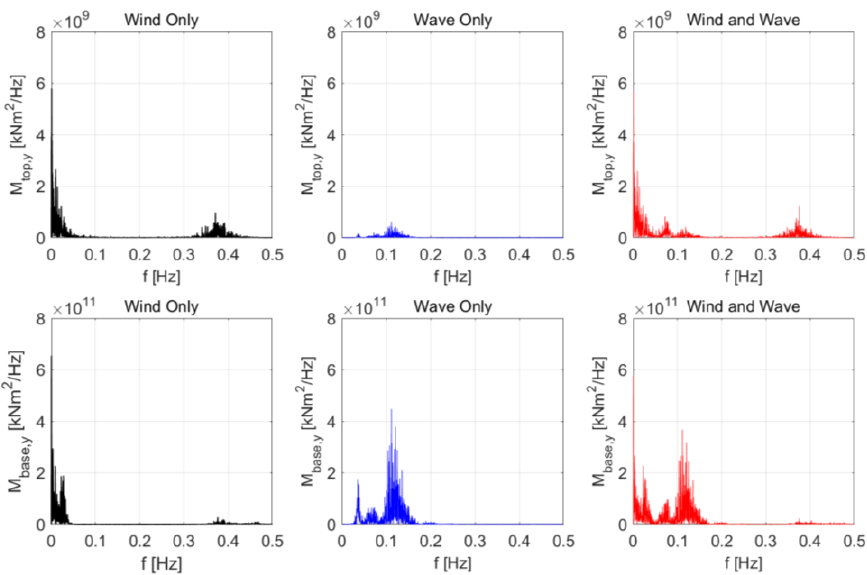
Figure 7. FFT results of tower-top and tower-base pitch moments for three specified conditions.